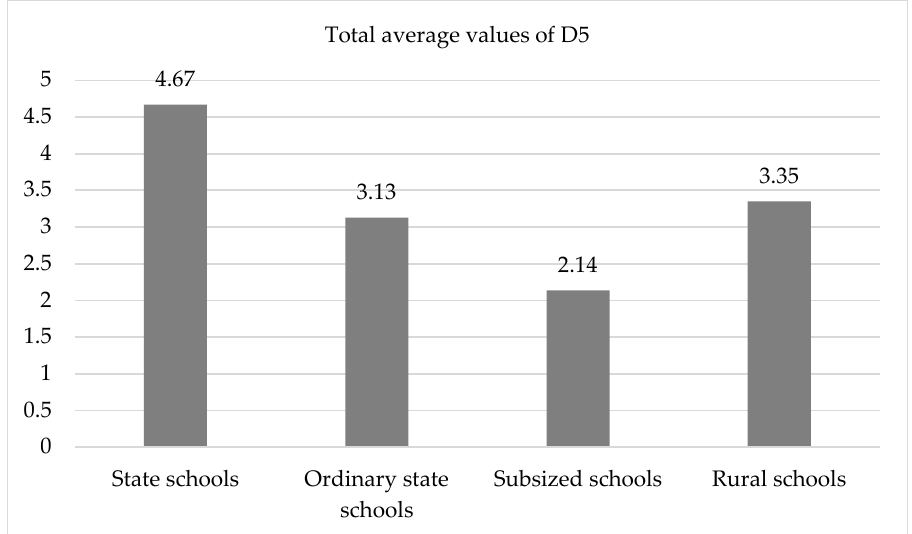
Figure 4. Diagram of means. Overall mean values of D3 as a function of type of school ( p < 0.001).